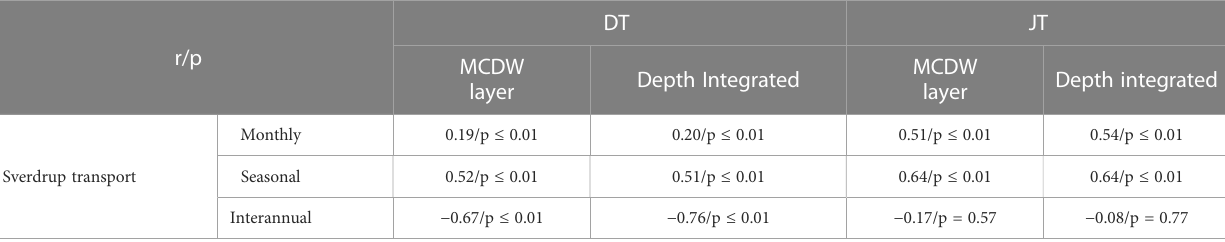
TABLE 2 Monthly, seasonal, and interannual regression analyses between along transect components of MCDW layer velocity anomalies and transport anomalies in DT and JT vs. Sverdrup transport anomalies.